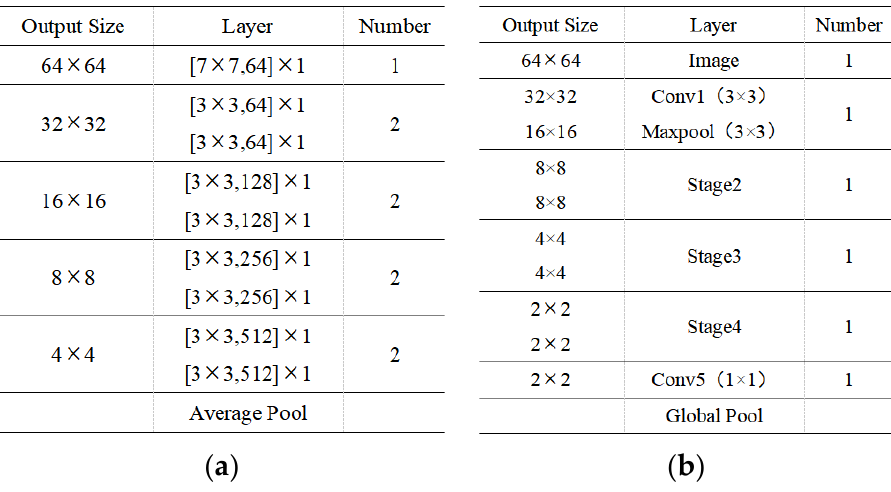
Figure 10. Network structure of the teacher and student models. ( a ) Resnet18 network structure (teacher model) and ( b ) Shuffv2_x0_5 network structure (student model).